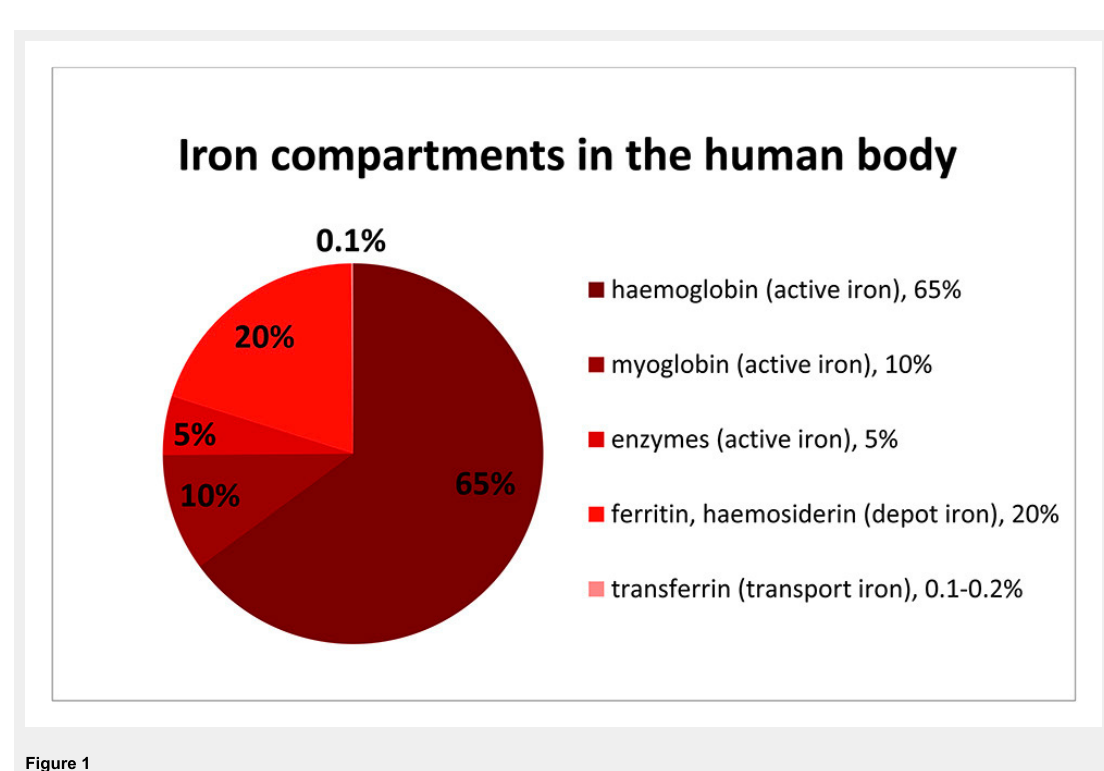
Figure 1 Iron compartments.